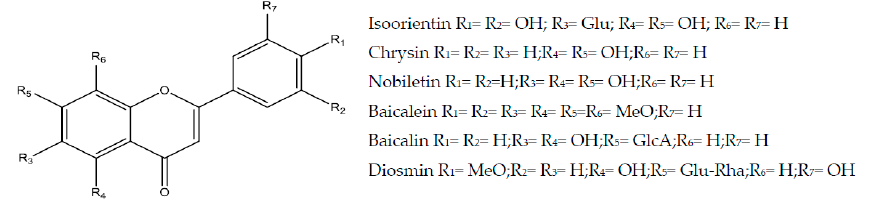
Figure 4. Flavones with gastroprotective and/or anti-ulcer activity.